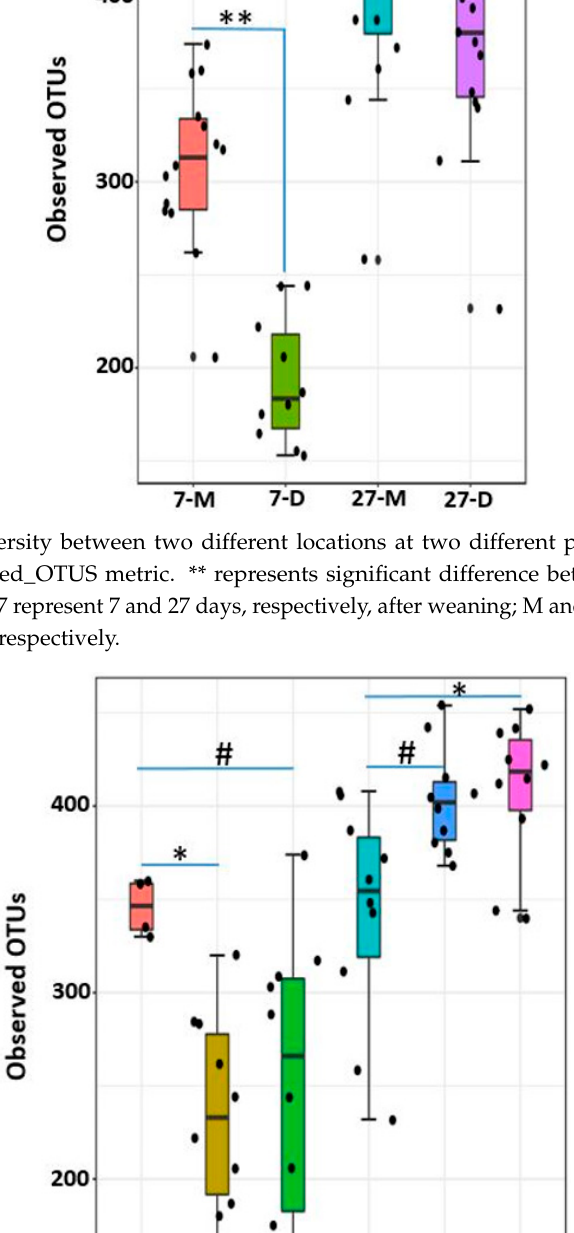
Figure 10. Alpha diversity between three different regions of GIT at two different post-weaning ages as measured by Observed_OTUS metric. #, * represent significant difference between two groups at p < 0.05 and p < 0.01, respectively. The 7 and 27 represent 7 and 27 days, respectively, after weaning; M and D represent mucosa and digesta samples, respectively; PJ, DJ, and C represent proximate jejunum, distal jejunum, and mid-colon, respectively.